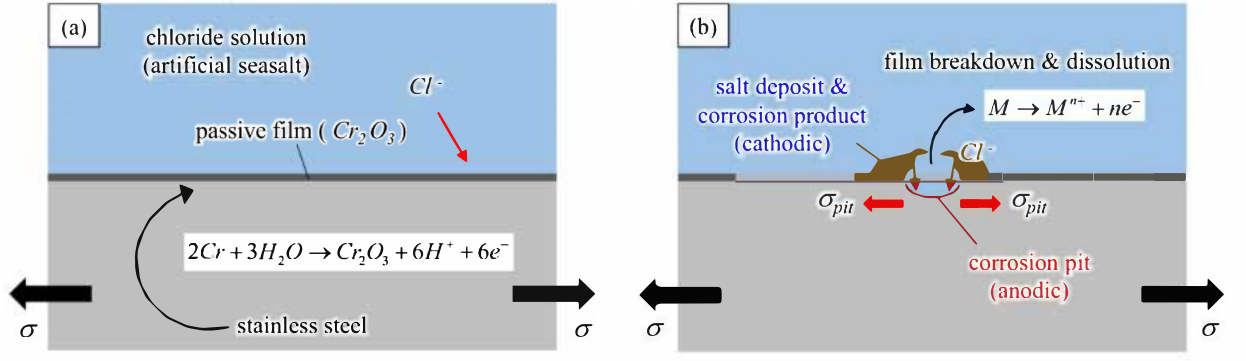
Figure 10. Schematic illustration of the pit growth process: ( a ) formation of the passive film [23] and ( b ) corrosion pit generation by film breakdown and metal dissolution